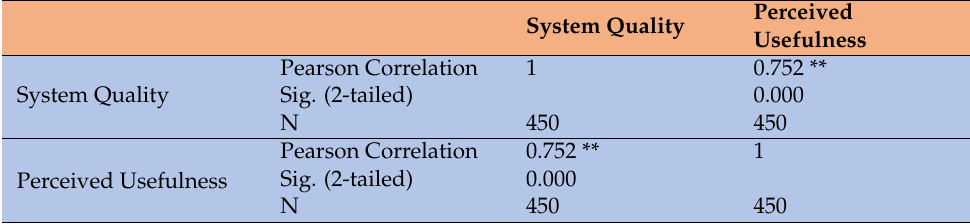
Table 7. Results of the correlation analysis for hypothesis 2